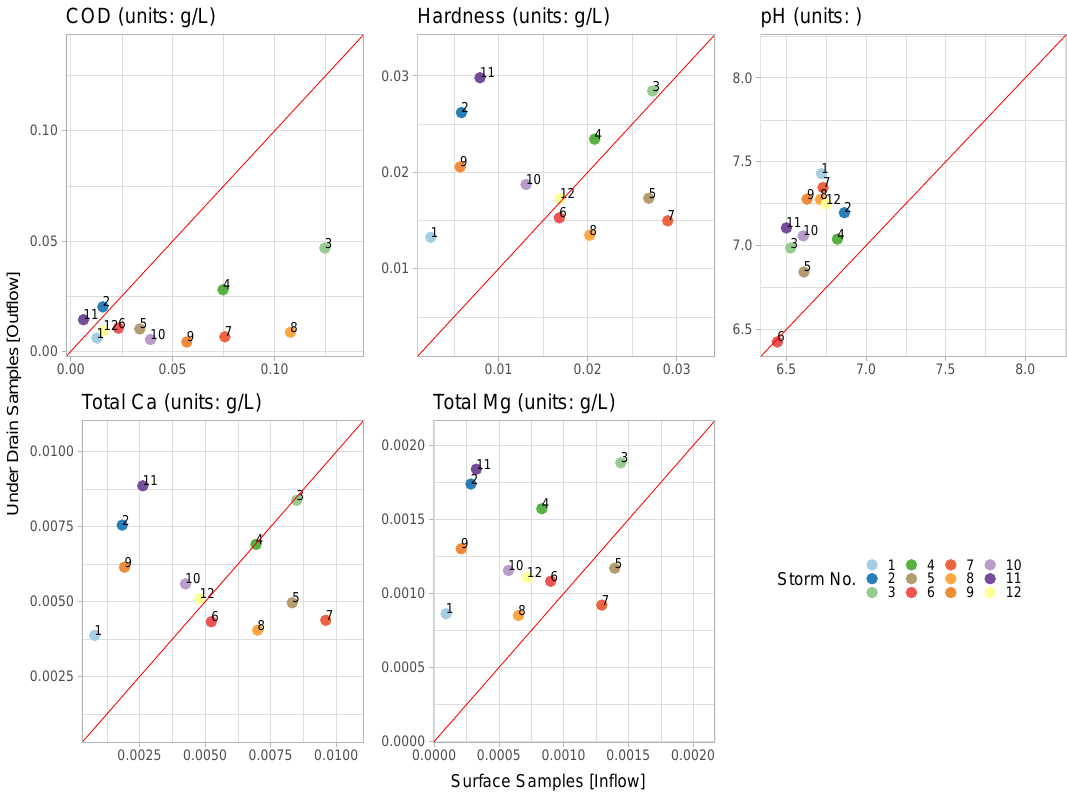
Figure 8. Comparisons of stormwater chemistry between outflow at the under drain position, and inflow (or stormwater from the surface of IA cells). Concentrations associated with storm events that plot above the 1:1 line (red line) suggest analyte export, while those below denote analyte